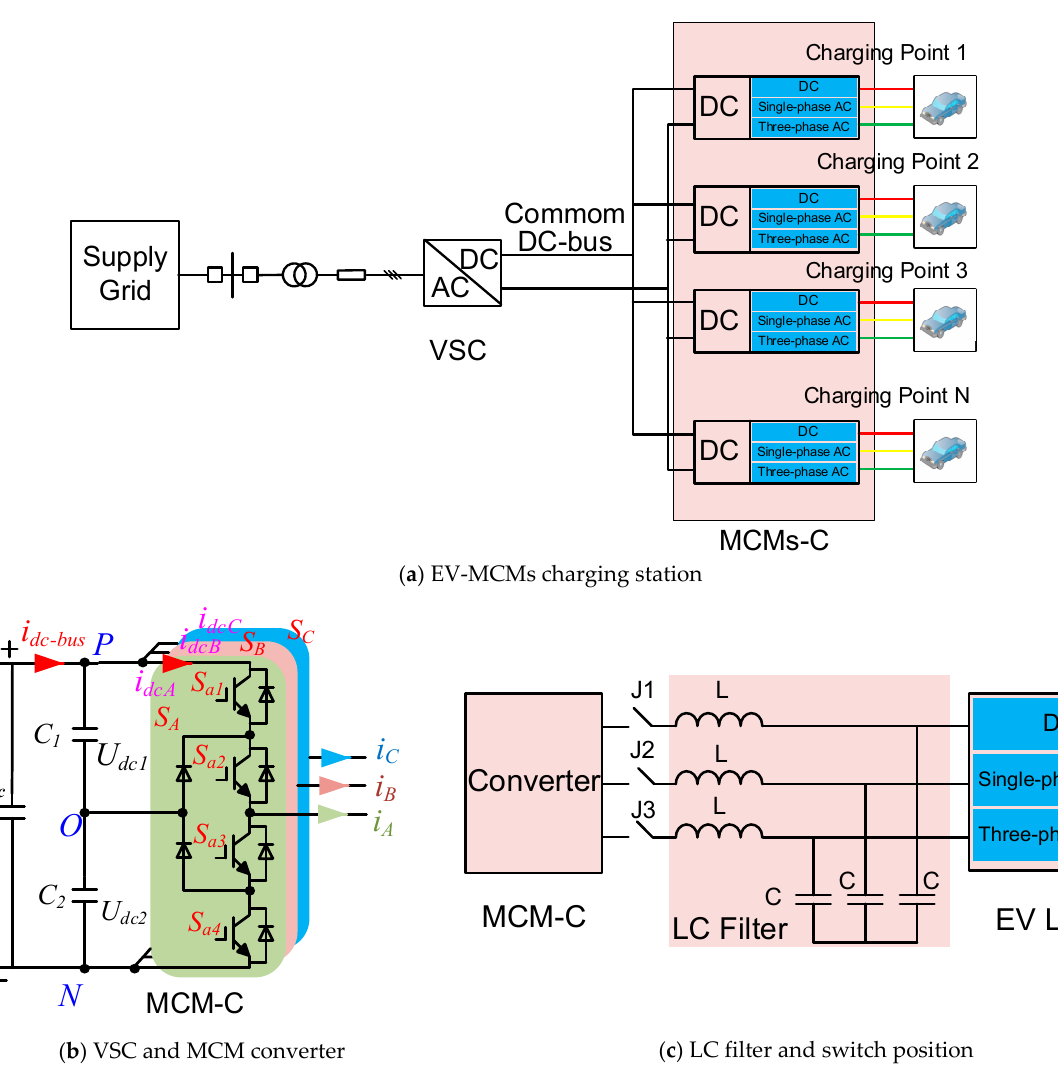
Figure 1. System Structure of EV-MCMs charging station.